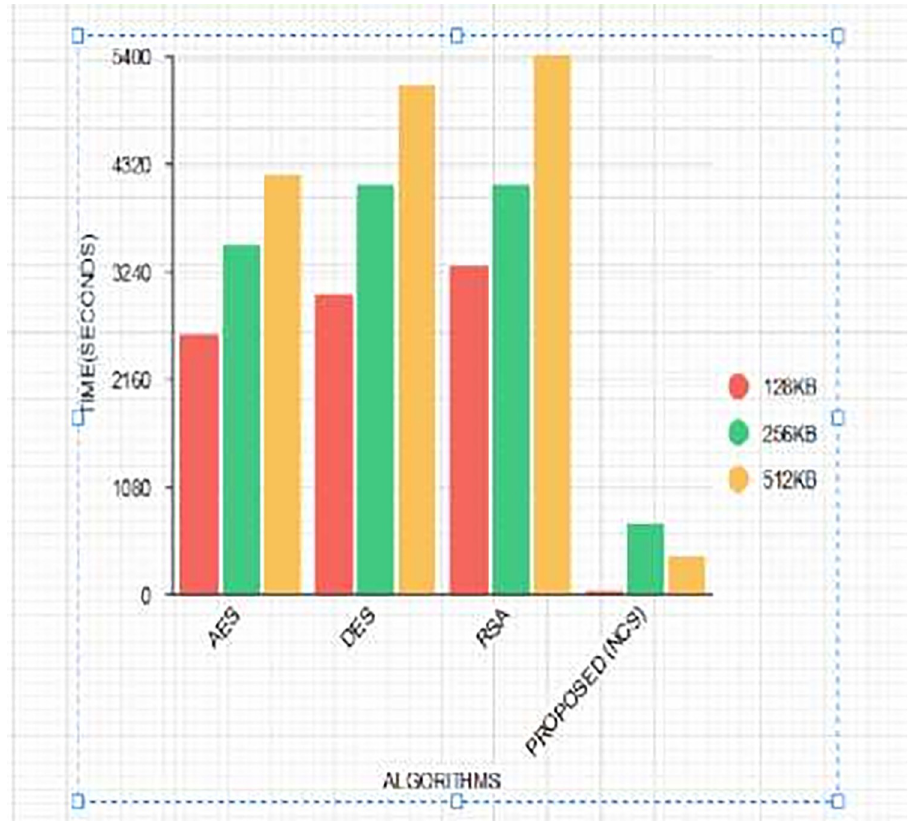
Fig 17. Comparing the decryption Time of the proposed (NCS) algorithm with conventional algorithms using different key sizes.